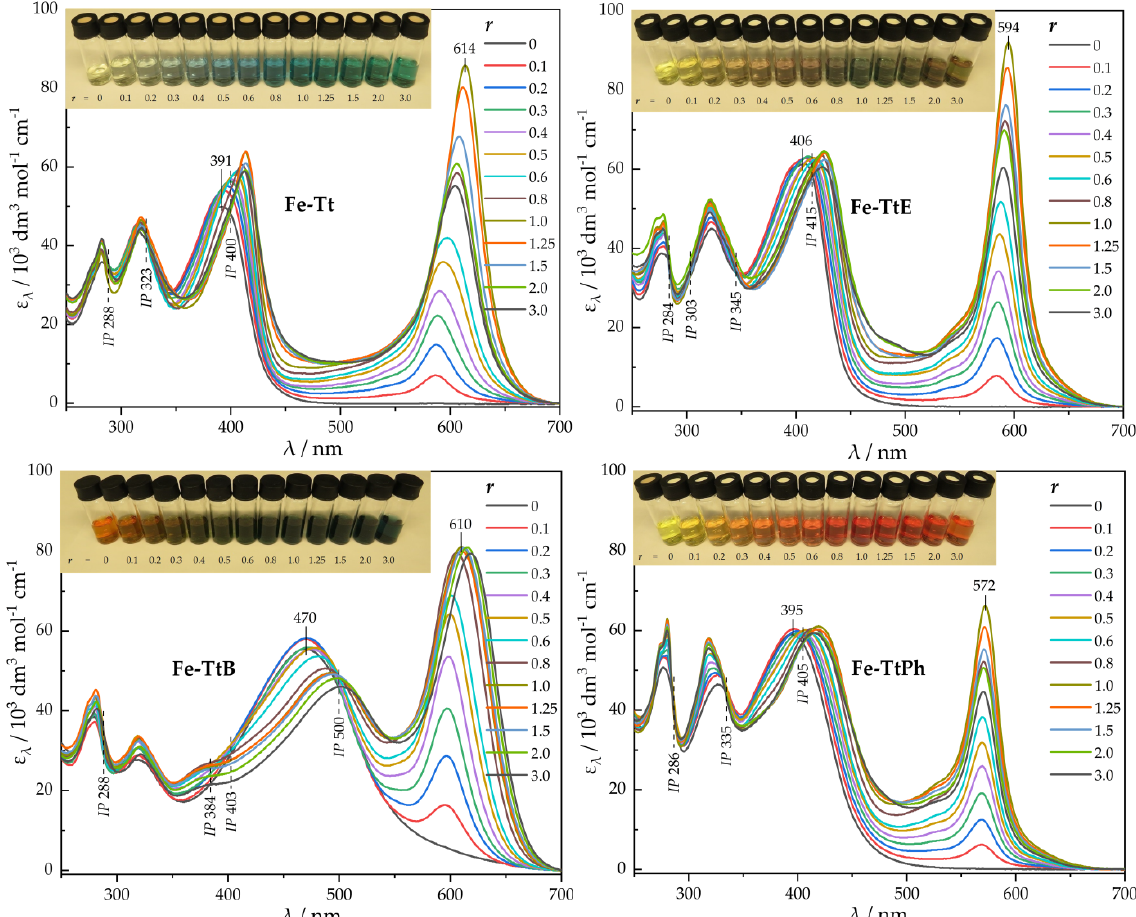
Figure 1. Changes in the UV/vis spectra accompanying stepwise transformation of studied unimers into Fe-MSPs in the HFP/ACN (4:1 by vol.) mixed solvent in response to increasing compositional ratio of solutes r = [Fe 2+ ]/[U]. Unimer concentration [U] = 2 × 10 − 5 mol/L in all solutions.